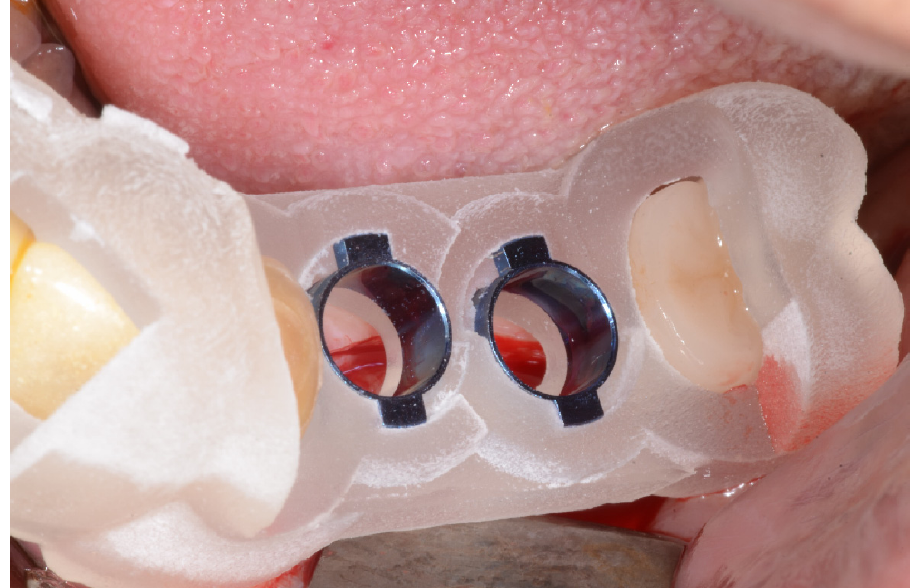
Figure 4. Surgical guide for full-guide implant surgery; tooth-supported.